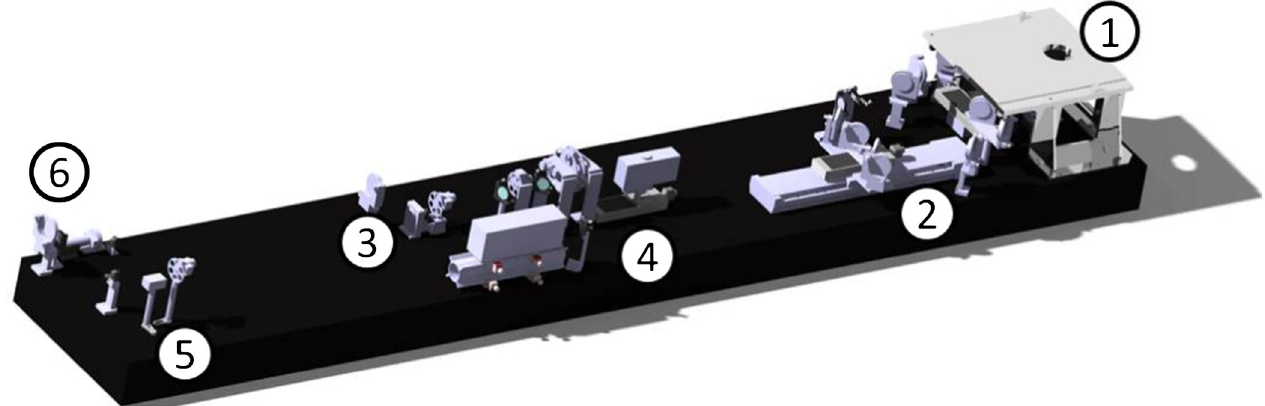
FIG. 2. Layout of the beam synchrotron radiation telescope (BSRT). The BSRT is located below the beampipe and the synchrotron light is directed down through the support (1) onto a motorized alignment mirror. It passes through a variable delay line or ‘‘trombone’’ (2) which is used to move the focus onto the dominant source of synchrotron light. The light is then split between the abort gap monitor (3), the transverse profile cameras (4), and the longitudinal density monitor (5). A calibration line (6) can be substituted for the synchrotron light.